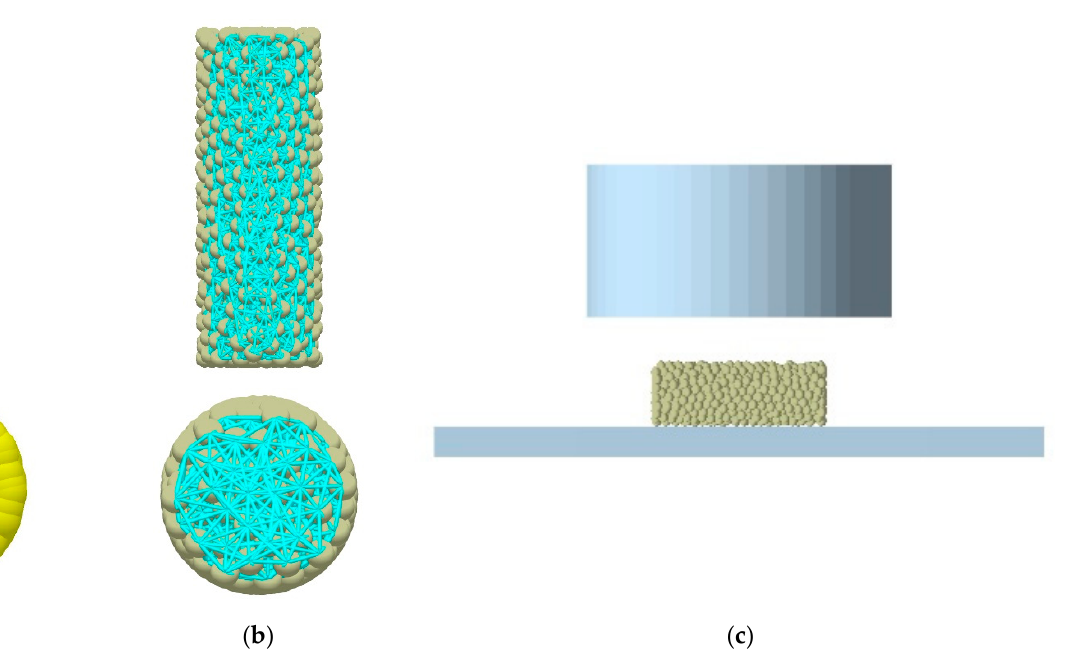
Figure 3. Discrete element model of gluten pellet. ( a ) Multi-spheres autofill model; ( b ) bonded particle model; and ( c ) compression simulation model.